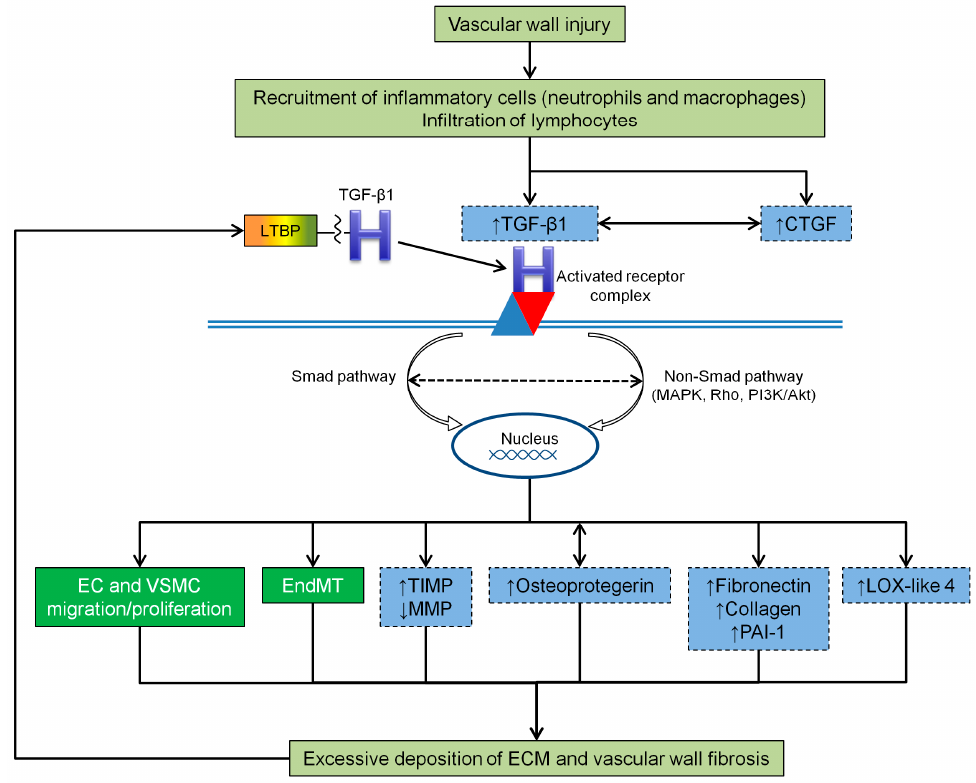
Figure 3. Mechanisms linking vascular wall injury, inflammation and vascular remodeling. TGF- β 1 (transforming growth factor-beta one), LTBP (latent TGF- β -binding protein), CTGF (connective tissue growth factor), EC (endothelial cells), VSMC (vascular smooth muscle cells), EndMT (endothelial-to-mesenchymal transition), TIMP (tissue inhibitors of metalloproteinases), MMP (metalloproteinases), PAI-1 (plasminogen activator inhibitor one), LOX-like 4 (lysyl oxidase-like four), ECM (extracellular matrix).